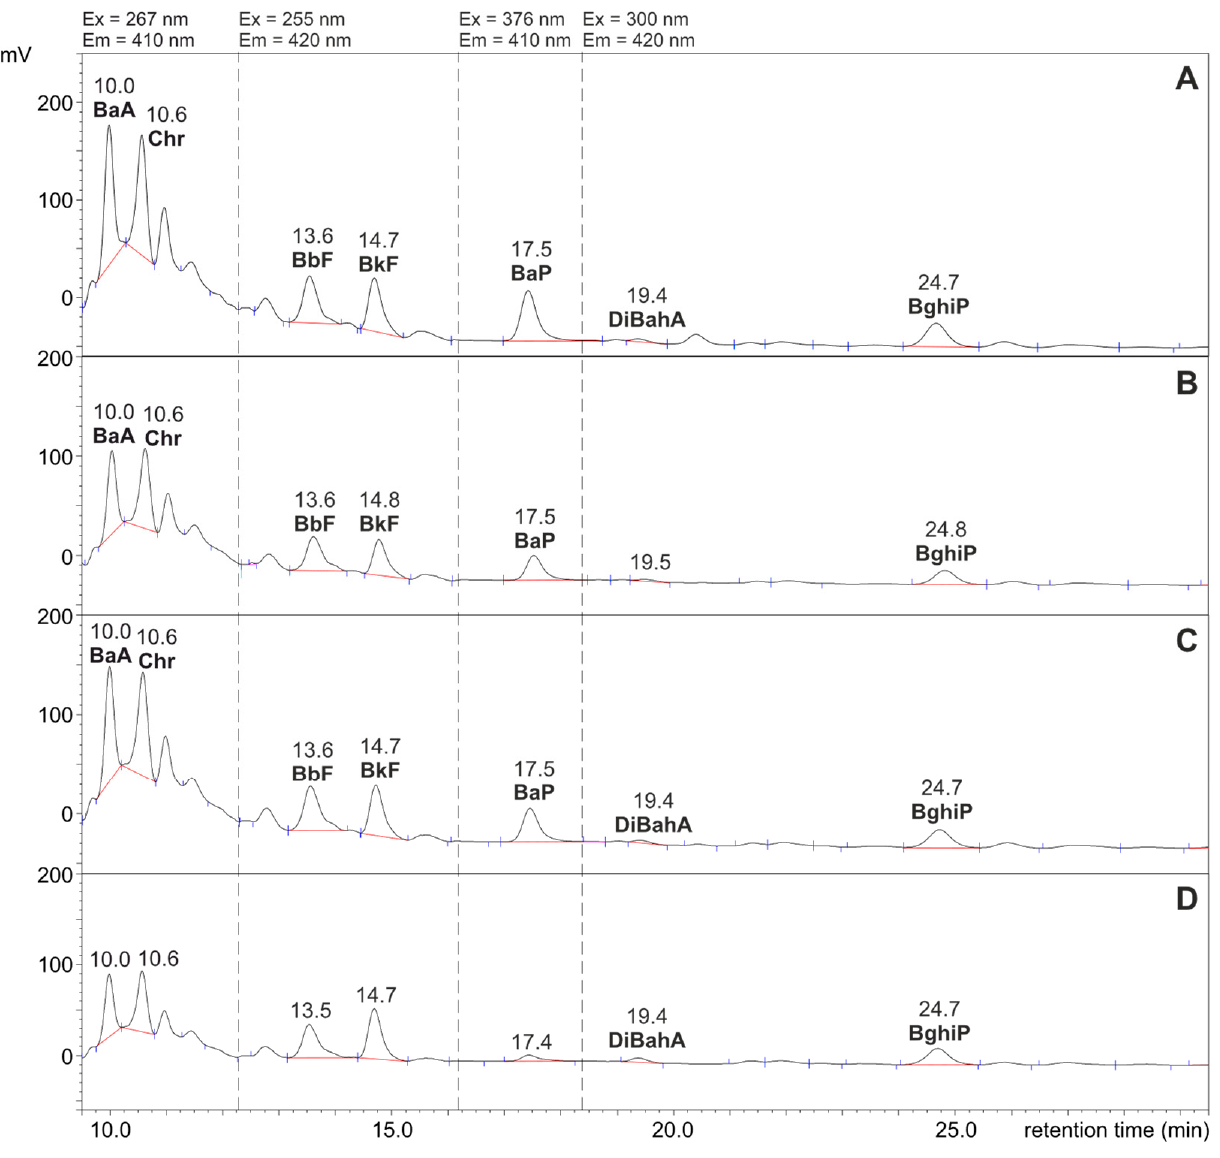
Figure 2. HPLC-FLD chromatograms of fractions containing PAHs separated from roasted pork loin samples. ( A ): Control sample (pork meat prepared without additives); ( B ): pork meat with prunes; ( C ): with apricots; ( D ): with cranberries. In each case, 10 μ L of 500 μ L was injected.